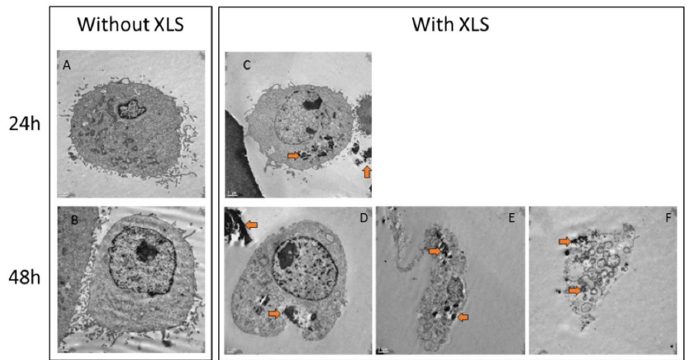
Figure 9. TEM micrographs of SW1353 cultured during one or two days into Dulbecco’s modified Eagle’s medium (DMEM) media containing XLS ( C – F ) or not ( A , B ). SW1353 fate was evaluated at 24 h ( A , C ) and 48 h ( B , D – F ). The samples were fixed, embedded, cut, and contrasted, as described in materials and methods. Aggregates of Laponites, appearing in black on TEM pictures (orange arrow), are internalized by cells and vesicles can be observed at 48 h. Scale bars correspond to 1 μm ( A , B , D , F ) and 2 μm ( C , E ).